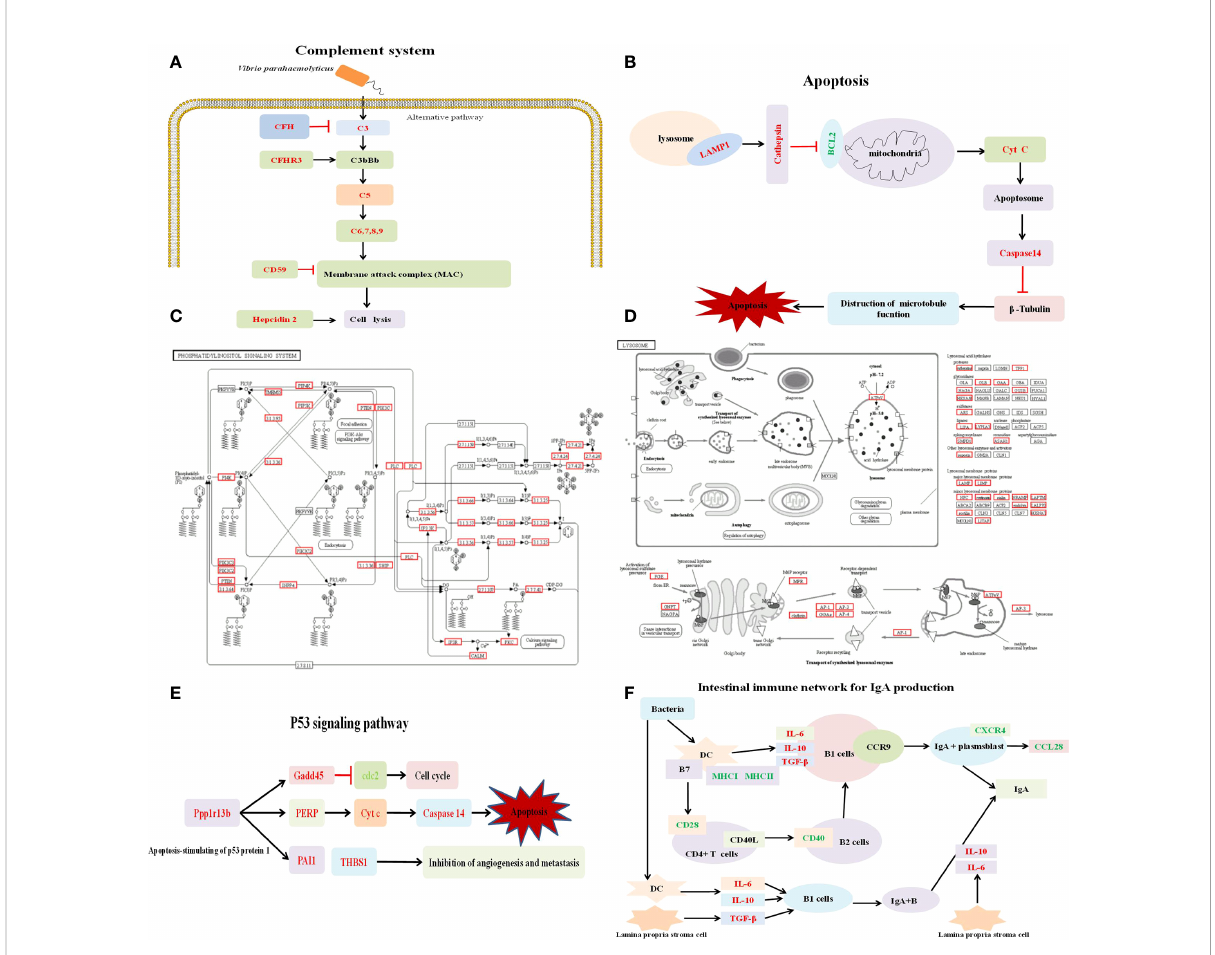
FIGURE 7 Simpli fi edoverviewof several pathways. (A) Simpli fi edoverviewof Complementsystempathway. (B) Simpli fi edoverviewof Apoptosispathway. (C) Simpli fi edoverviewof Phosphatidylinositol signalingsystempathway. Theredbox representssigni fi cantly enrichedtargetgenes. (D) Simpli fi edoverviewof Lysosomepathway. Theredboxrepresentssigni fi cantlyenrichedtargetgenes. (E) Simpli fi ed overviewof p53 signalingpathway. (F) Simpli fi edoverviewof Intestinal